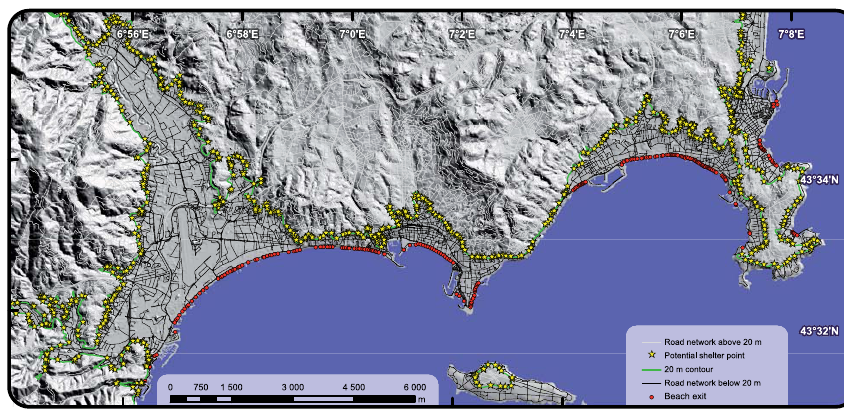
Fig. 3. Road network, potential shelter points and exits from the beaches.